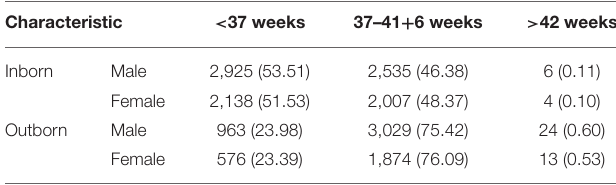
TABLE 12 | The proportion (%) of male and female of inborn/outborn newborns in each gestational age (weeks).